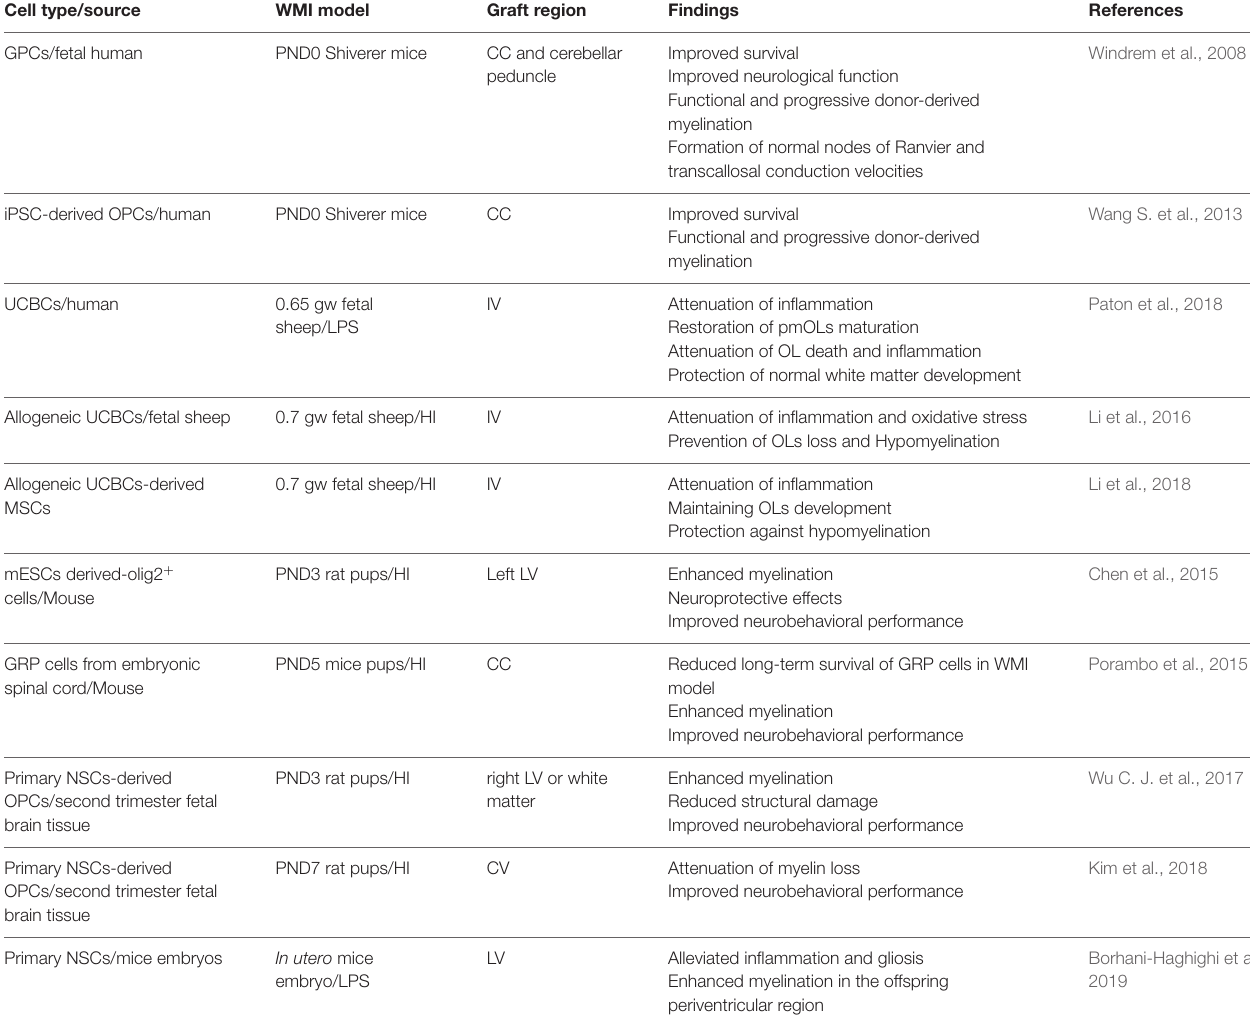
TABLE 1 | Preclinical experiments on cell therapy strategies to restore